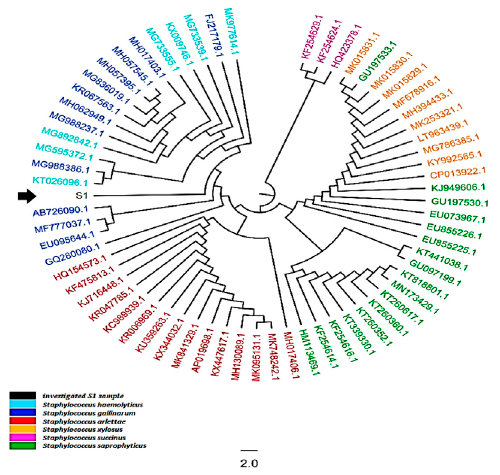
Fig. 3. The comprehensive phylogenetic tree of the 16S rRNA genetic fragments for Staphylococcus haemolyticus local isolates. The black color and arrows refer to the sequenced query local samples, while other colors refer to other referring NCBI Staphylococcus deposited referring